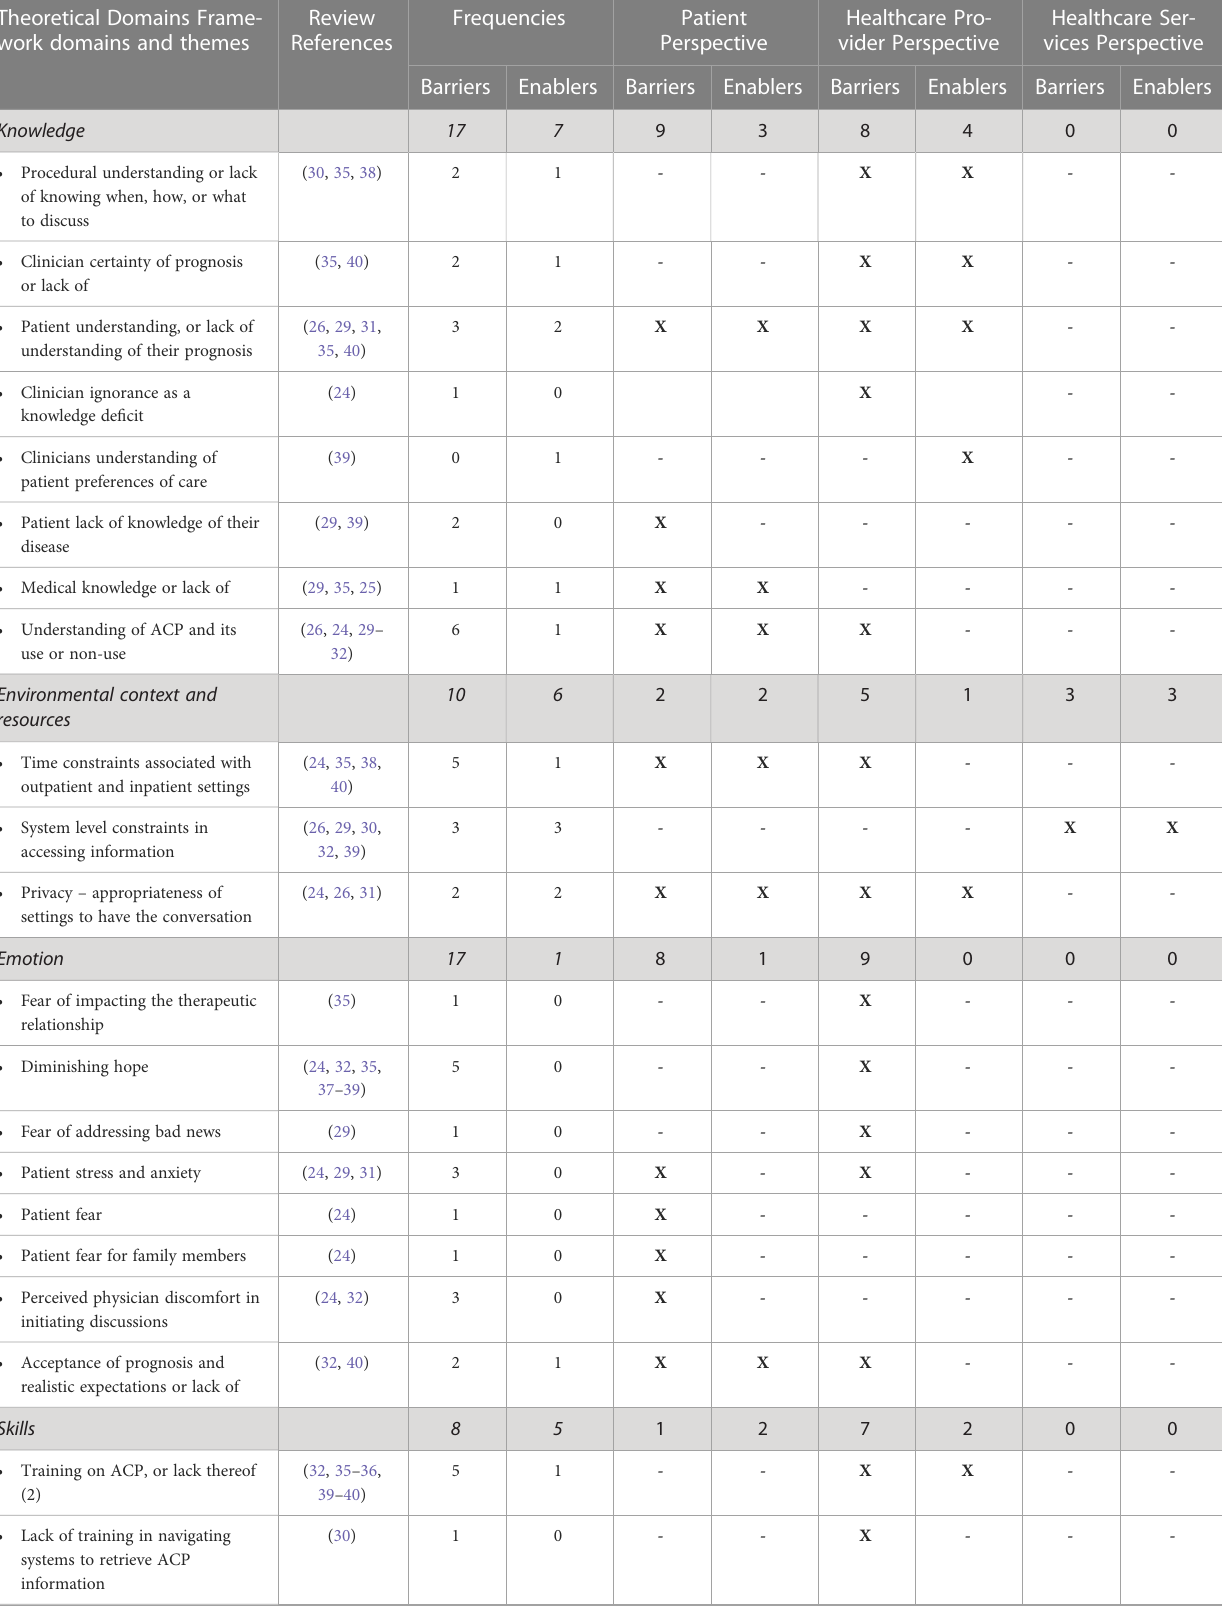
TABLE 3 Theoretical Domains Framework domains and themes of barriers and enablers across patient, healthcare provider, and healthcare services